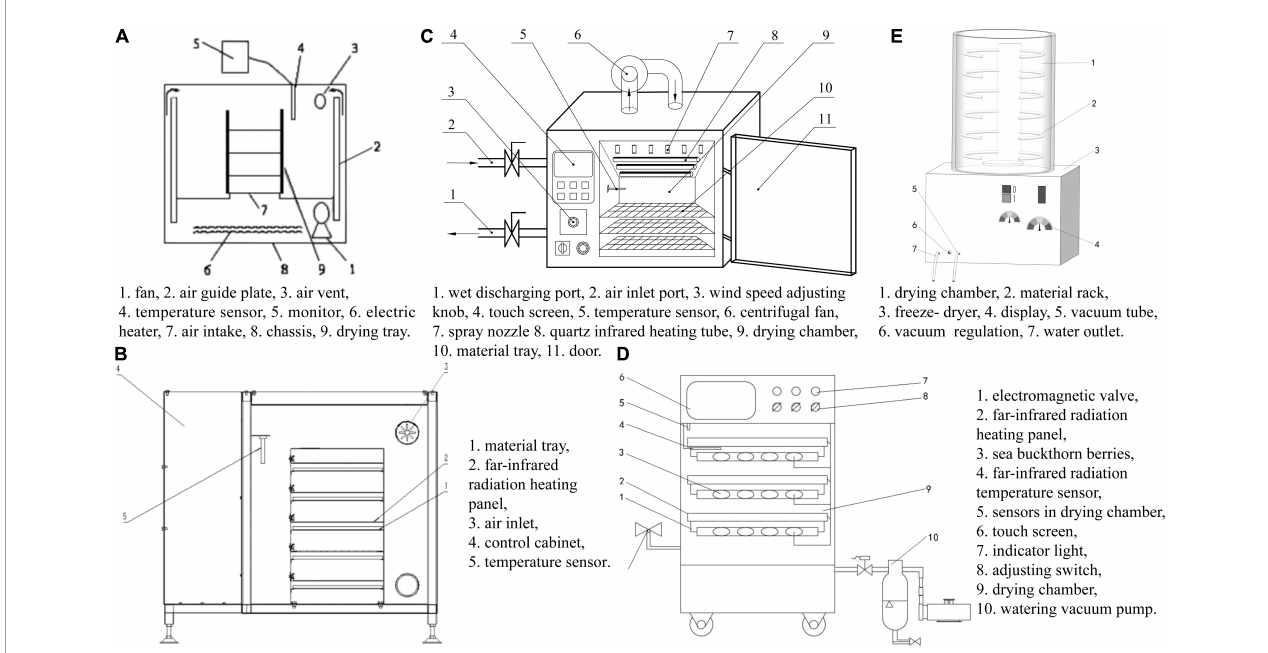
FIGURE2 The schematics diagram of the five dryers. (A) Hot-air drying (HAD) [adapted from Zhang et al. (17)], (B) infrared drying (IRD) [adapted from Li (18)], (C) infrared-assisted hot-air drying (IR-HAD) [adapted from Chang et al. (19)], (D) pulsed-vacuum drying (PVD) [adapted from Deng et al. (16)], (E) vacuum freeze-drying (VFD) [adapted from Schössler et al.